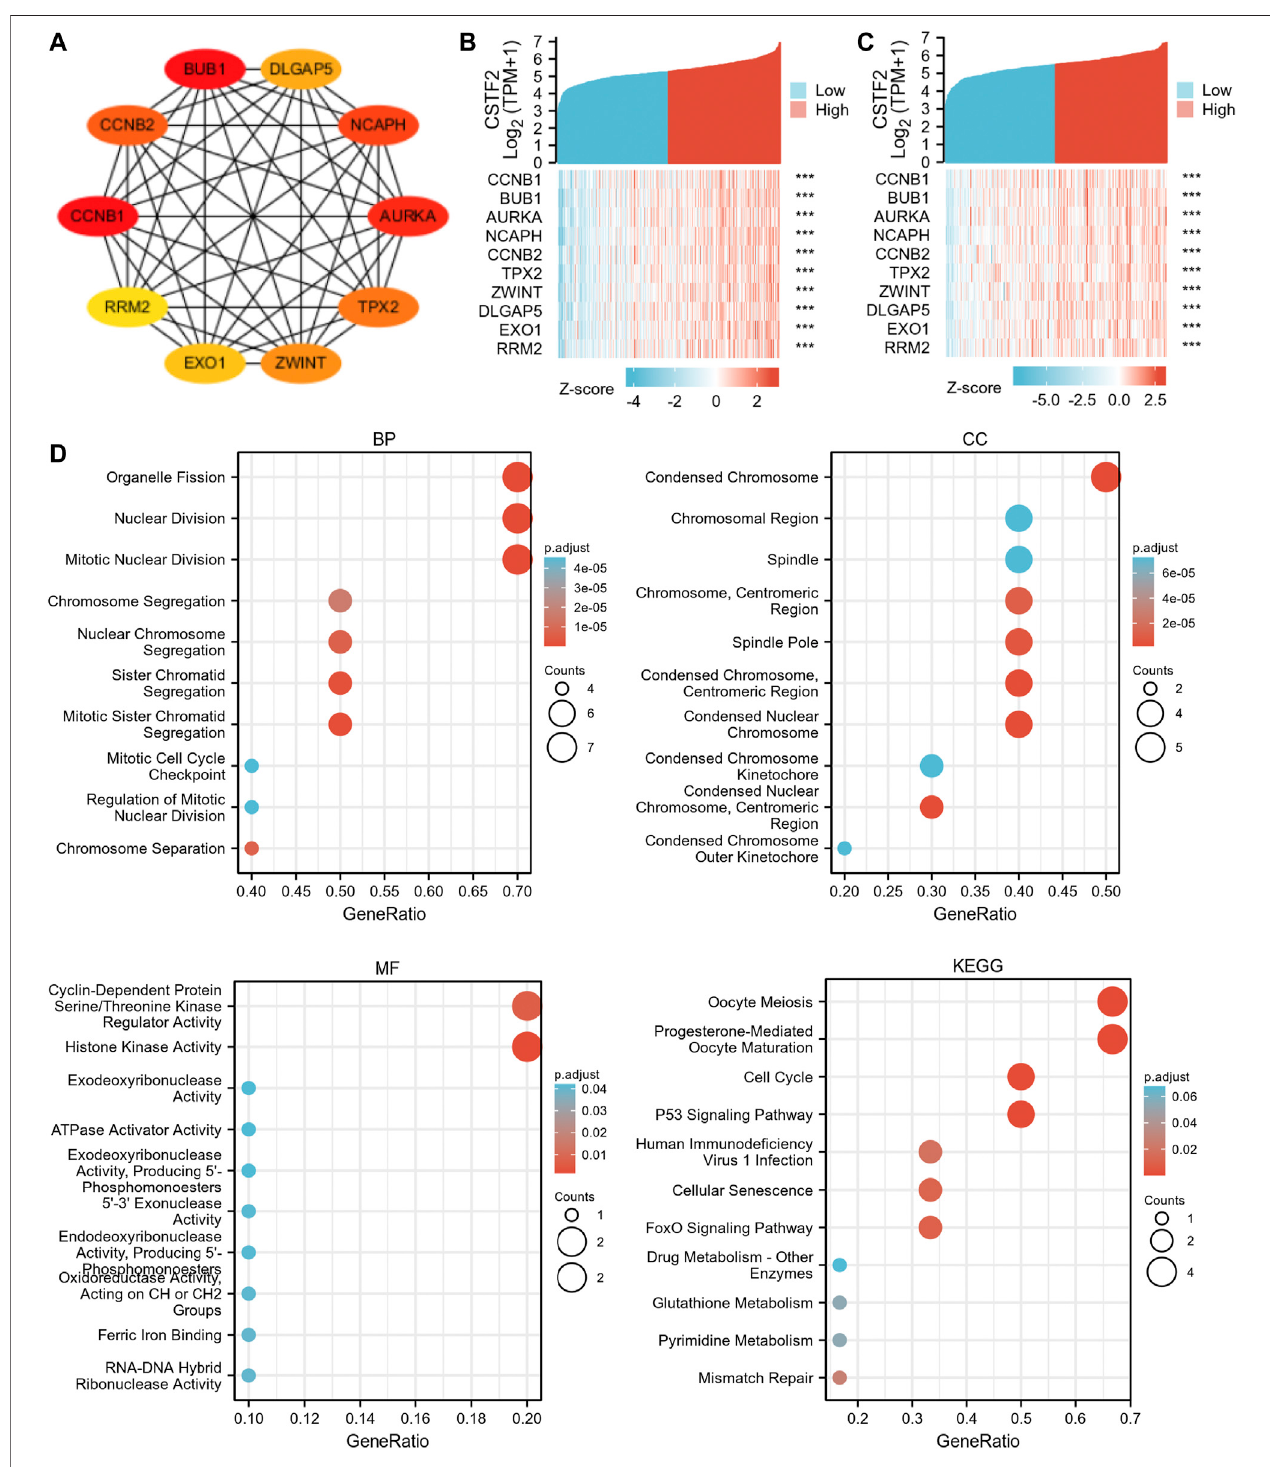
FIGURE 3 | Intracellular function of CSTF2 . (A) Interactive network of hub genes; (B,C) Co-expression analysis of hub genes and CSTF2 in cervical cancer and head and neck cancer. (D) GO/KEGG enrichment analysis, and the results were presented in the form of bubble plots.